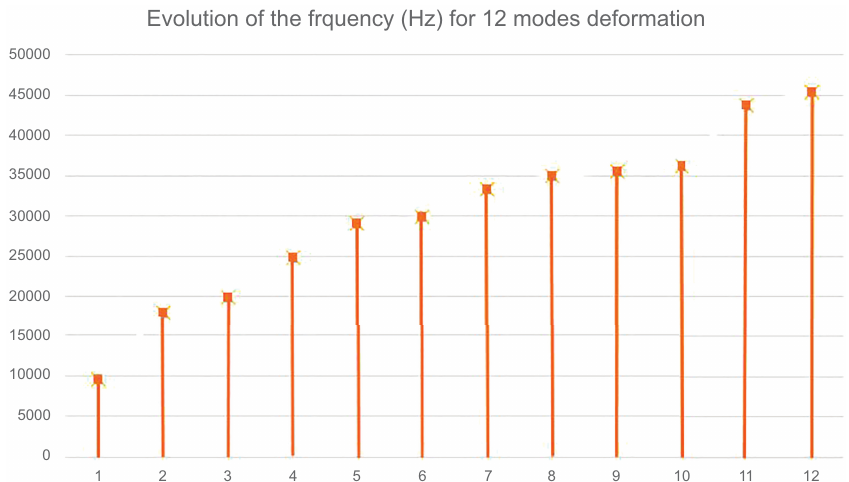
Figure 14. Frequencies of the 12 modes of deformation of the